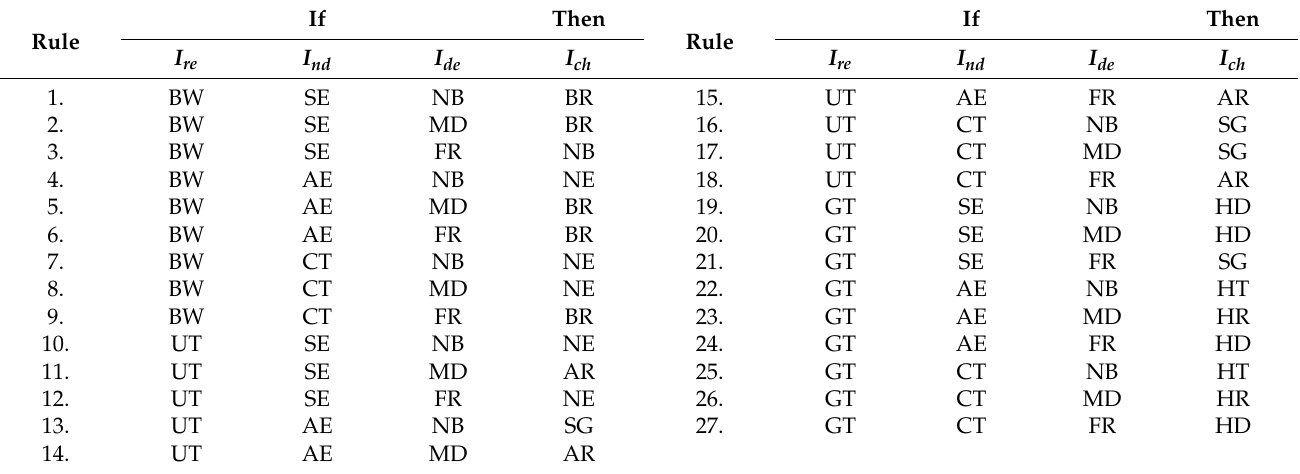
Table 2. Fuzzy logic rules.